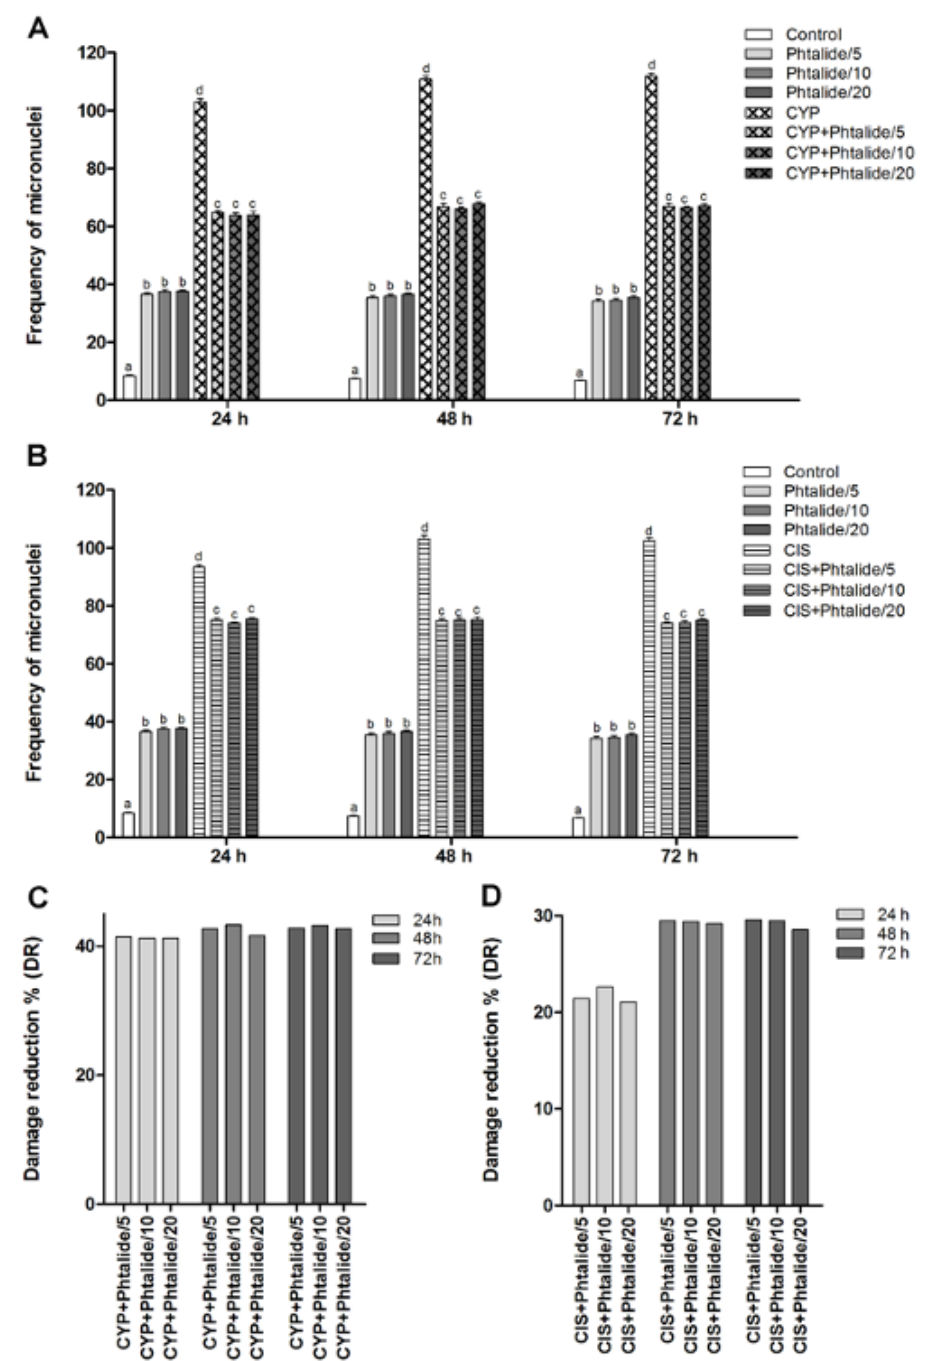
Figure 3. Frequency of micronuclei and percentage of damage reduction in different experimental groups. ( A ) Genotoxicity assessment: Chromosomal lesions in the compounds tested with 1 and 1 associated with cyclophosphamide; ( B ) Genotoxicity assessment: Chromosomal lesions in the compounds tested with 1 and 1 associated with cisplatin; ( C ) Percentage of damage reduction of 1 associated with cyclophosphamide; ( D ) Percentage of 1 damage reduction associated with cisplatin. Legend: g: Gram; CYP: Cyclophosphamide; CIS: Cisplatin; Phthalide 1 : 3-heptylidene-4,6- dimethoxy-3 H -isobenzofuran-1-one; 1 /5–5 mg/Kg; 1 /10–10 mg/Kg; 1 /20–20 mg/Kg. Results are presented as mean ± SEM. Different letters indicate statistically significant differences (Statistical test: ANOVA/Tukey, p < 0.05).